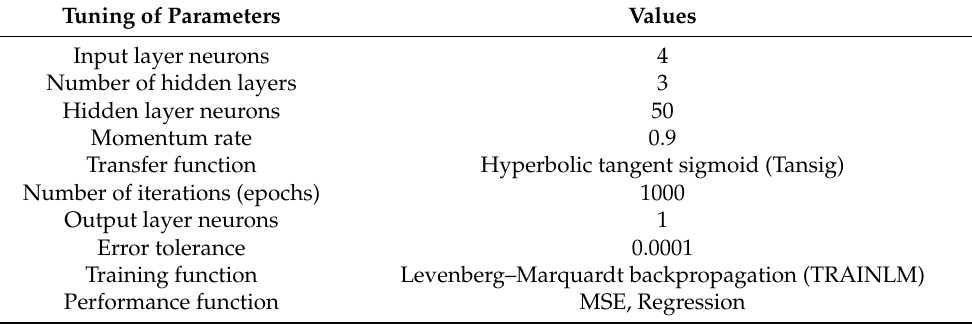
Table 3. Optimal parameter selection for Artificial Neural